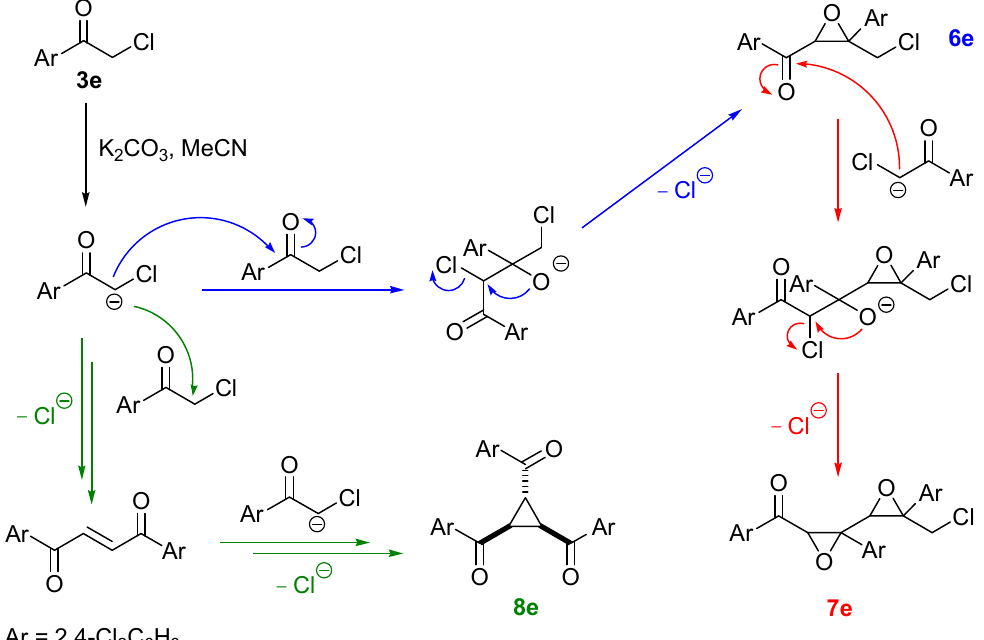
Figure 1. The ORTEP view of the molecule of 1-(4-bromophenyl)-2-(4,6-dibromo-1 H -benzimidazol-1-yl)ethanone ( 5d ). The non-hydrogen atoms are shown as 30% probability ellipsoids (CCDC2171992).